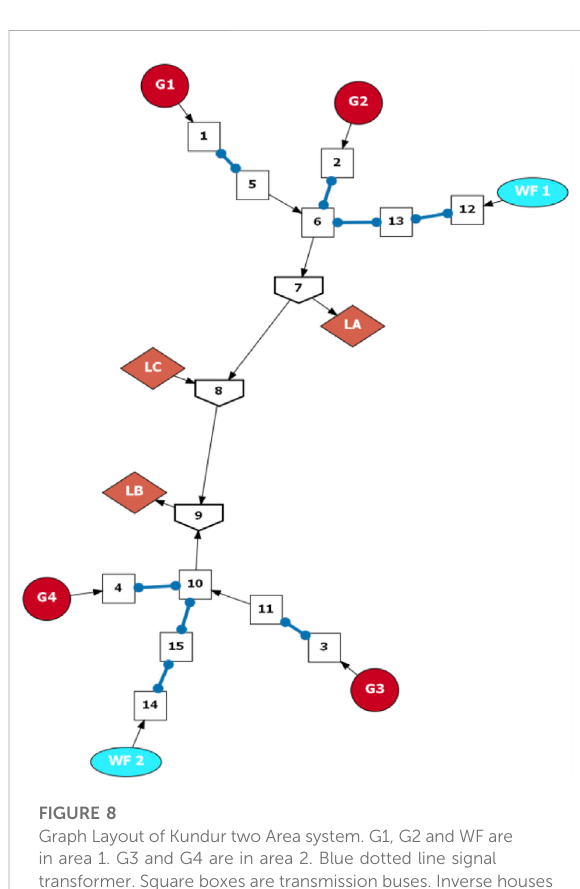
FIGURE 8 Graph Layout of Kundur two Area system. G1, G2 and WF are in area 1. G3 and G4 are in area 2. Blue dotted line signal transformer. Square boxes are transmission buses. Inverse houses are load